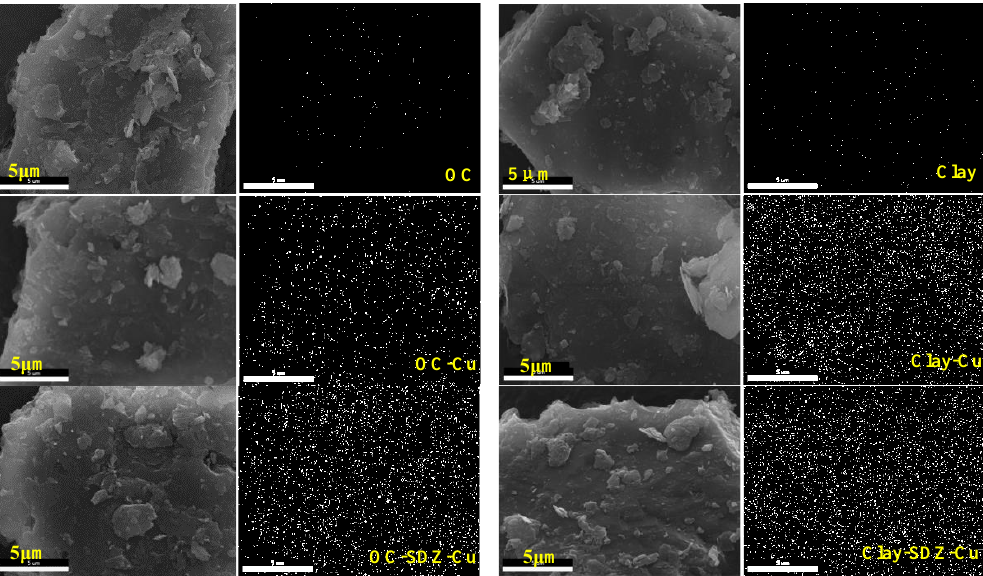
Figure 4. SEM images of OC and clay before and after reaction in Cu 2+ and SDZ, elemental mappings showing the distributions of Cu.